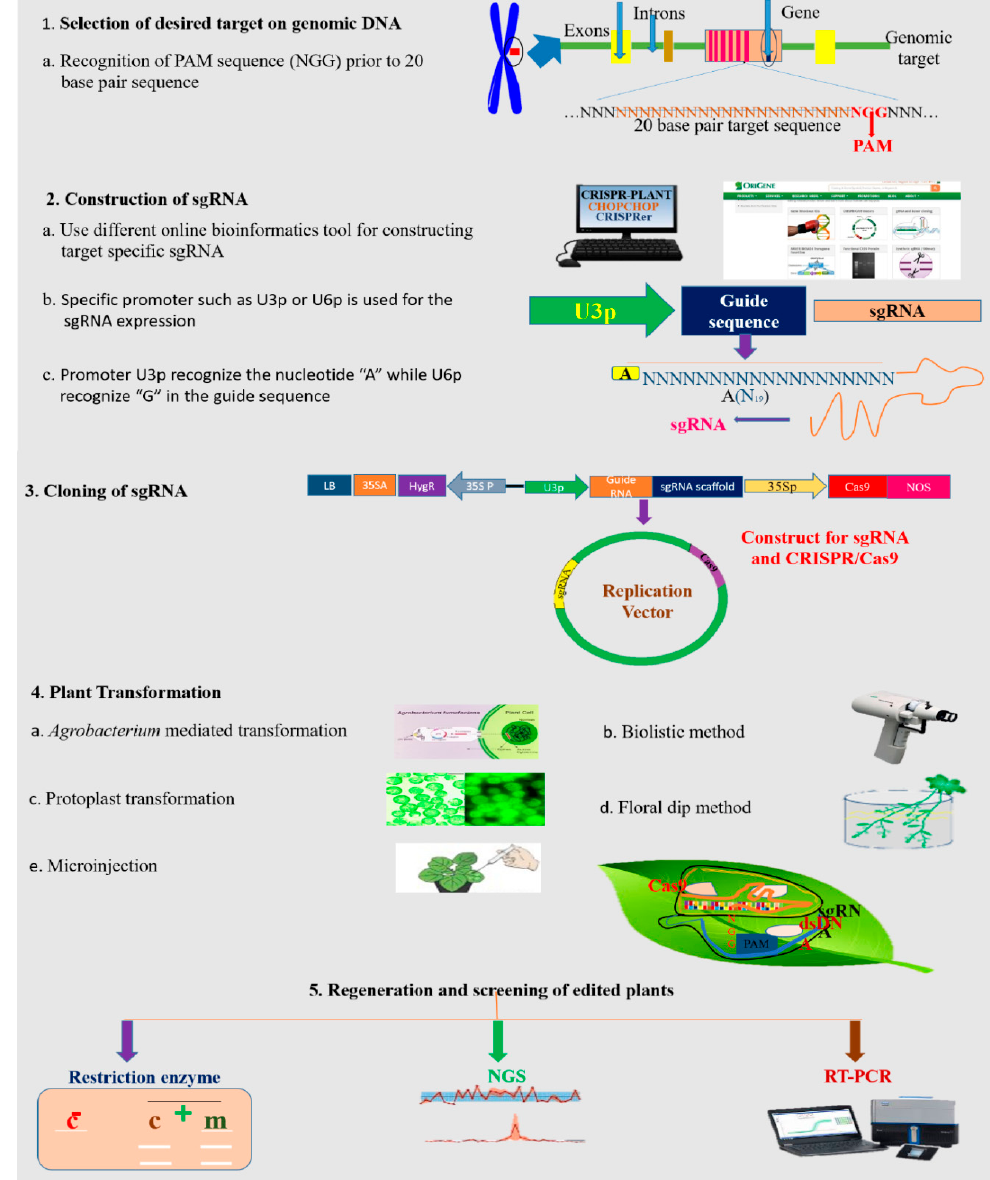
Figure 6. Basic steps in the workflow of CRISPR/Cas9-based genome editing.